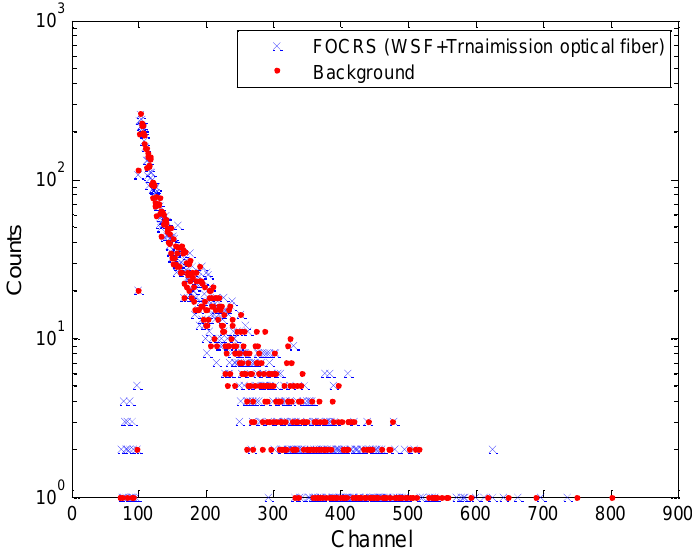
Figure 7. The response of the FOCRS incorporating the WSF for 88 keV gamma-rays emitted from a